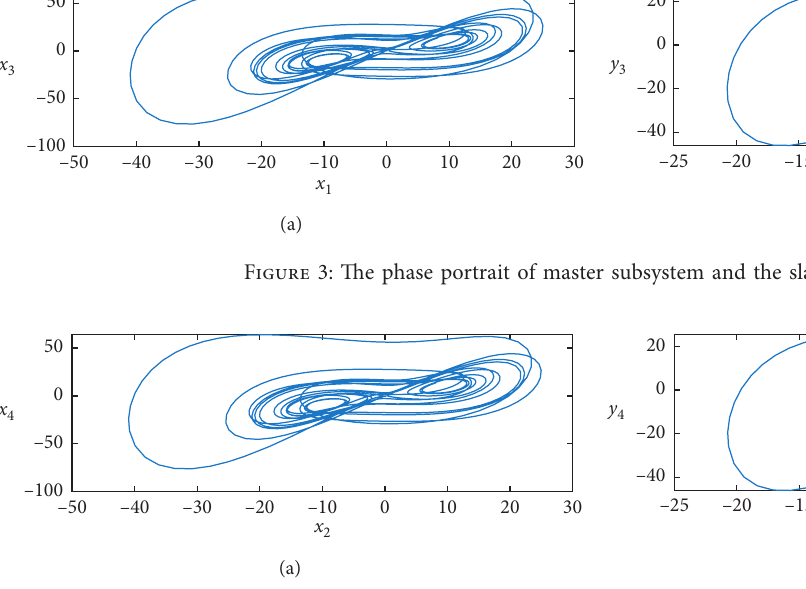
Figure 4: The phase portrait of master subsystem and the slave subsystem.